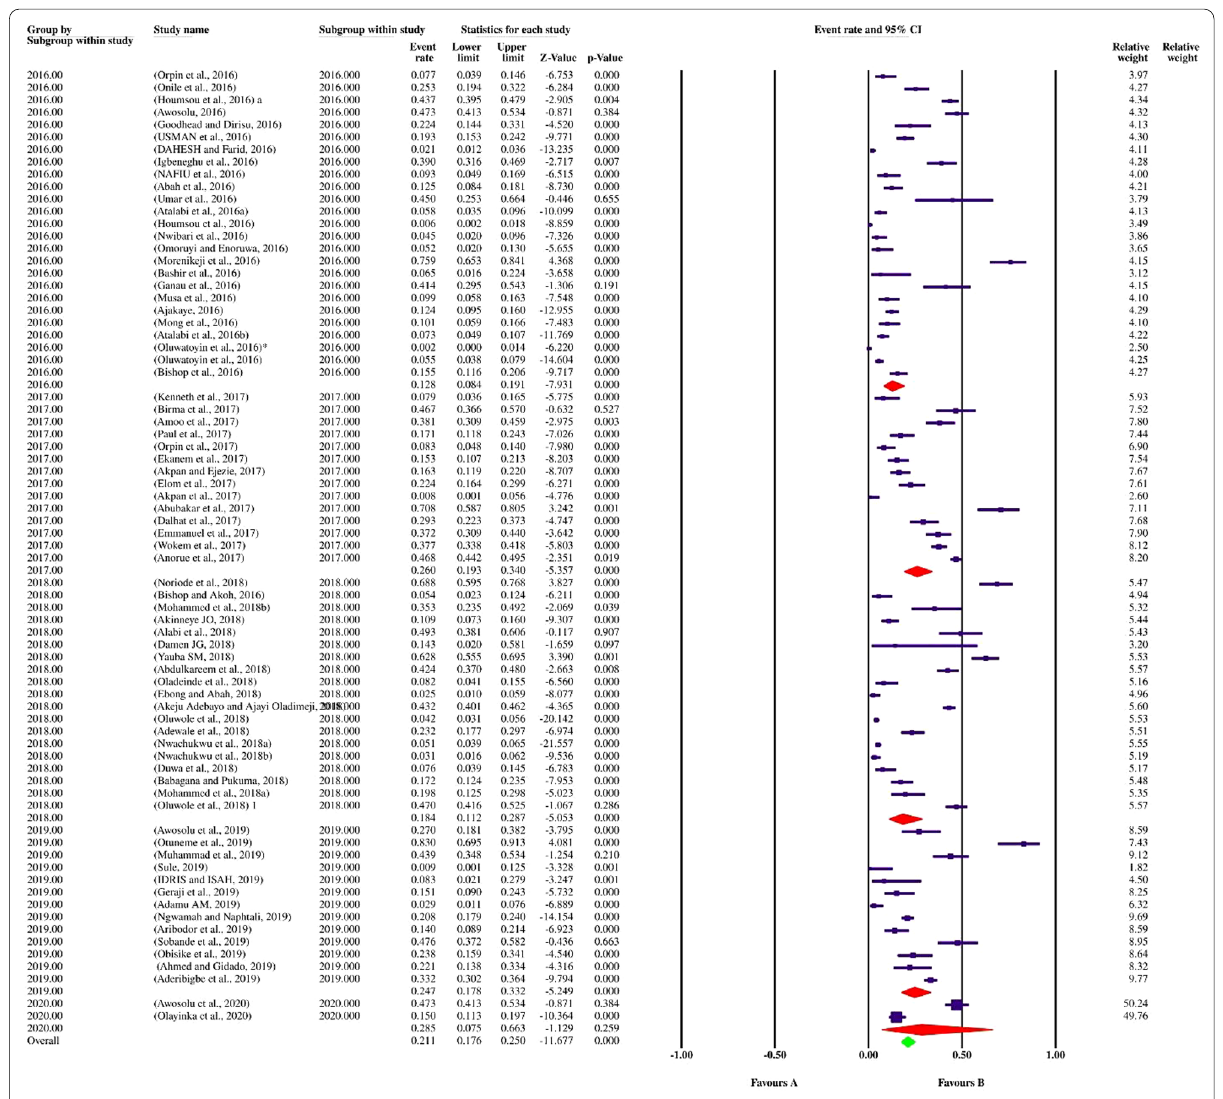
Fig. 3 Forest plot of year-based prevalence in Nigeria (2016–2020)